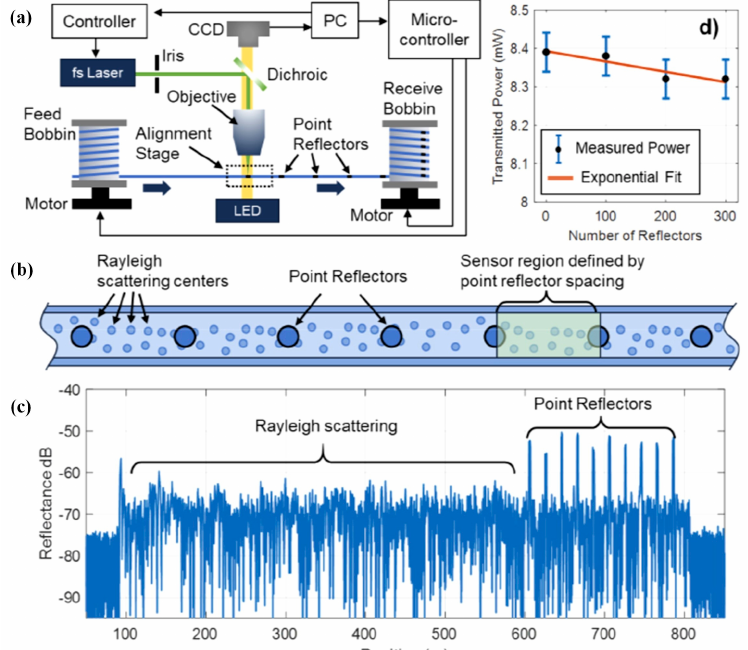
Figure 10. Preparation method for a weak reflection array based on a femtosecond laser [40]: ( a ) weak reflection array preparation system; ( b ) schematic diagram of weak reflection array preparation method; ( c ) OTDR measurement results for the weak reflection array; ( d ) the result of a cut ‐ back measurement on a separate fiber containing 300 reflectors.